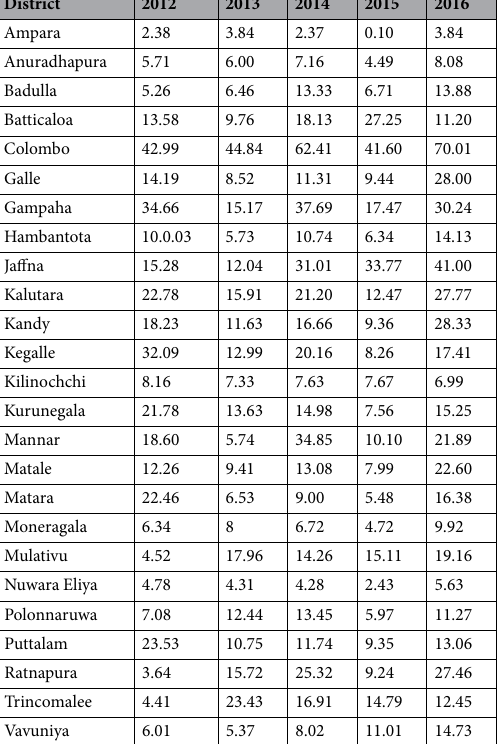
Table 2. The dengue incidences for each district of Sri Lanka from 2012 to 2016. Dengue incidence is the number of cases per 10000 population. The population data for each district of Sri Lanka were collected from Department of Census and Statistics 37